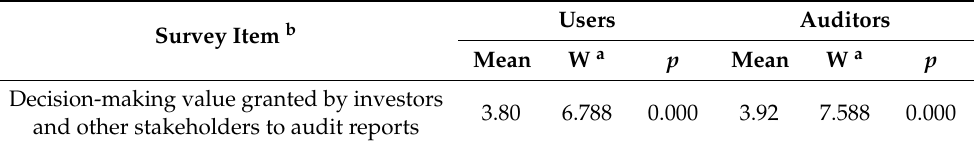
Table 4. Perceptions of the value granted by stakeholders to audit reports.